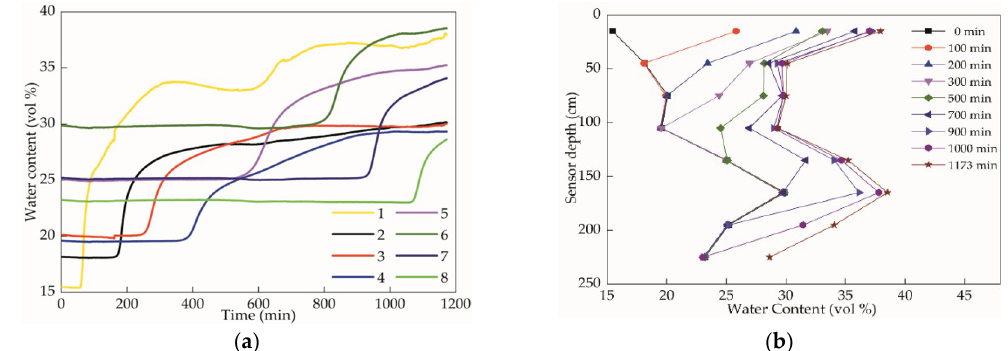
Figure 7. The field experiment results: ( a ) the variance of the volumetric water content with time; ( b ) water content isochrones.